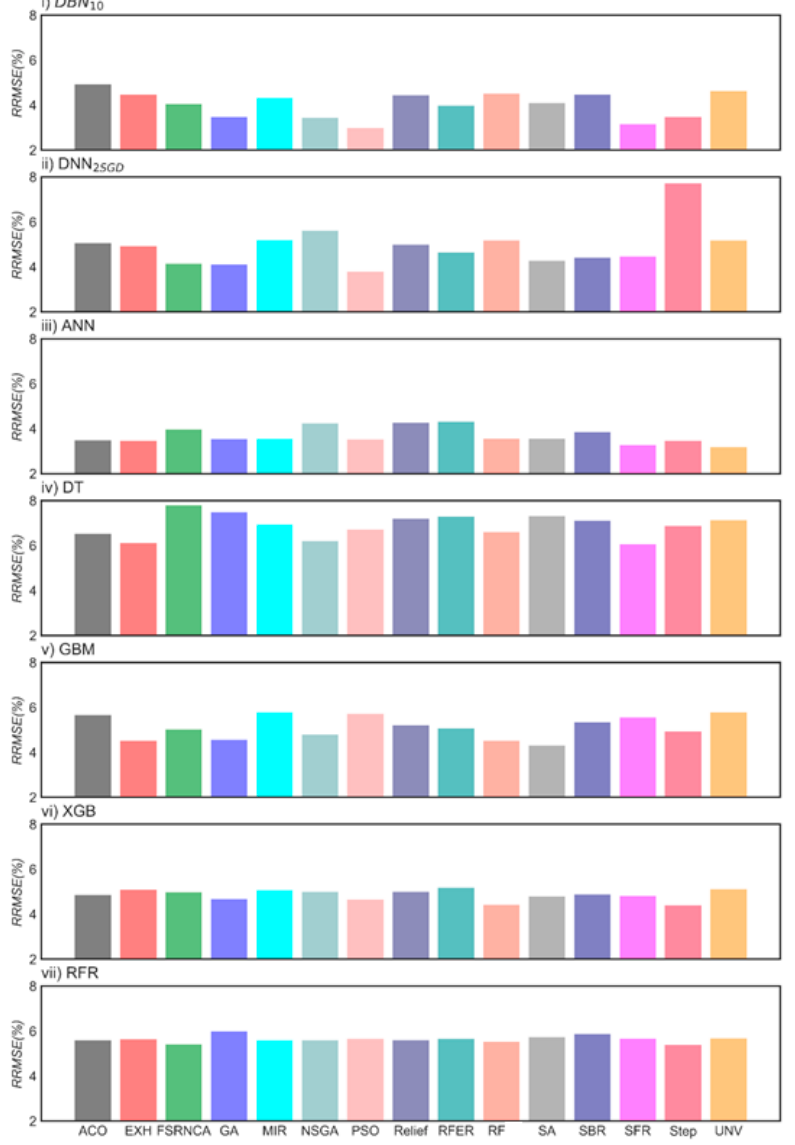
Figure 3. Relative root mean square error ( RRMSE %) in the model’s testing phase, illustrated for a selected solar city, Adelaide, to identify the accurate performance using di ff erent feature selection algorithms. Note: For acronyms and model names, refer to Tables 1–3 and Table